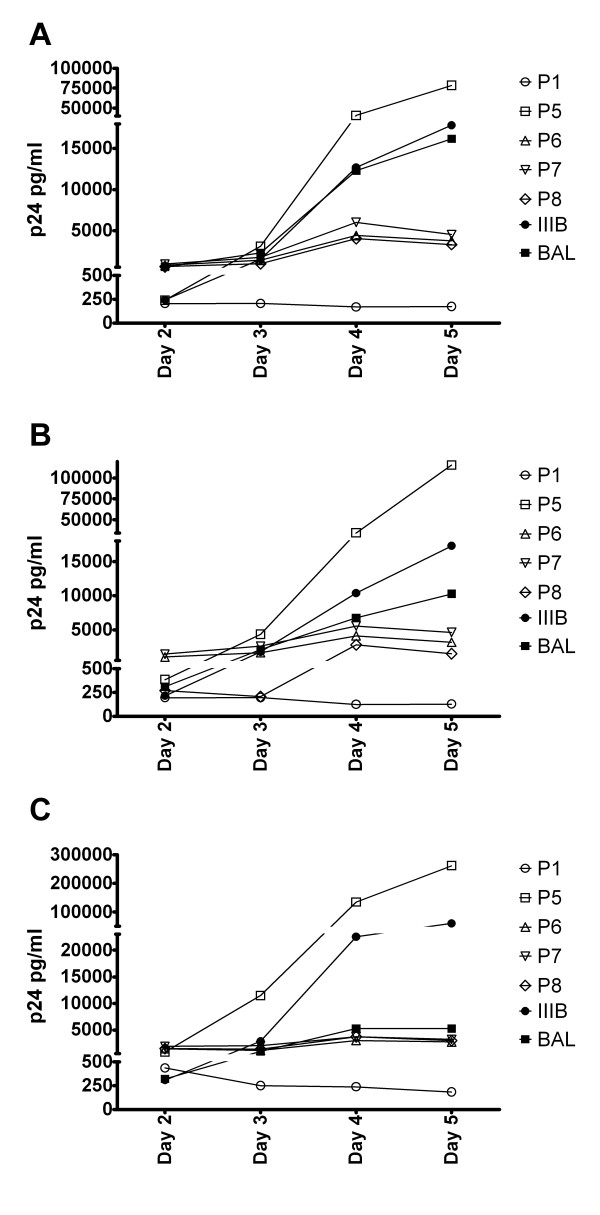
Relative replication fitness. The relative replication fitness was determined in PHA blasts from 3 healthy donors by measuring the p24 production produced by HIV reference strains BAL and IIIB or patient viruses (P1 is secondary controller, P5-P8 is from rebounders). (A): p24 production in ng/ml in donor 1. (B): p24 production in ng/ml in donor 2. (C): p24 production in ng/ml in donor 3.